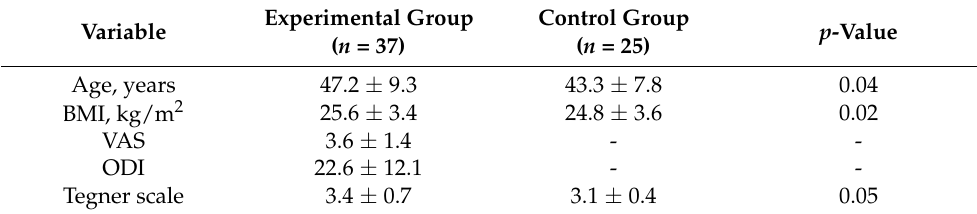
Table 1. Demographic data of the participants in each group (Mean ±